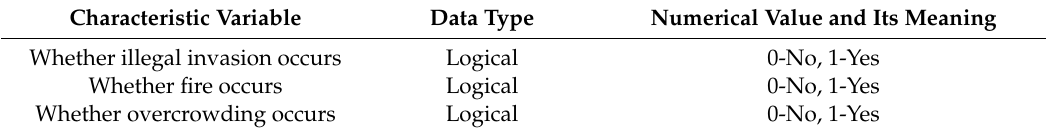
Figure 16. Prediction results for the danger coefficient.